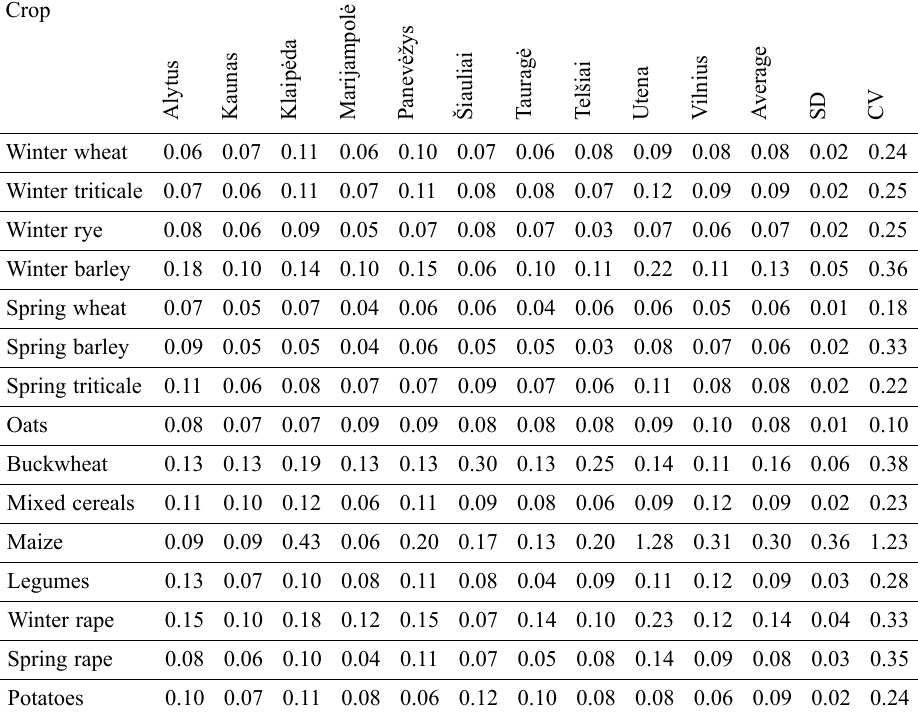
Table 2. Mean yield loss rates for different counties, 2000–2015